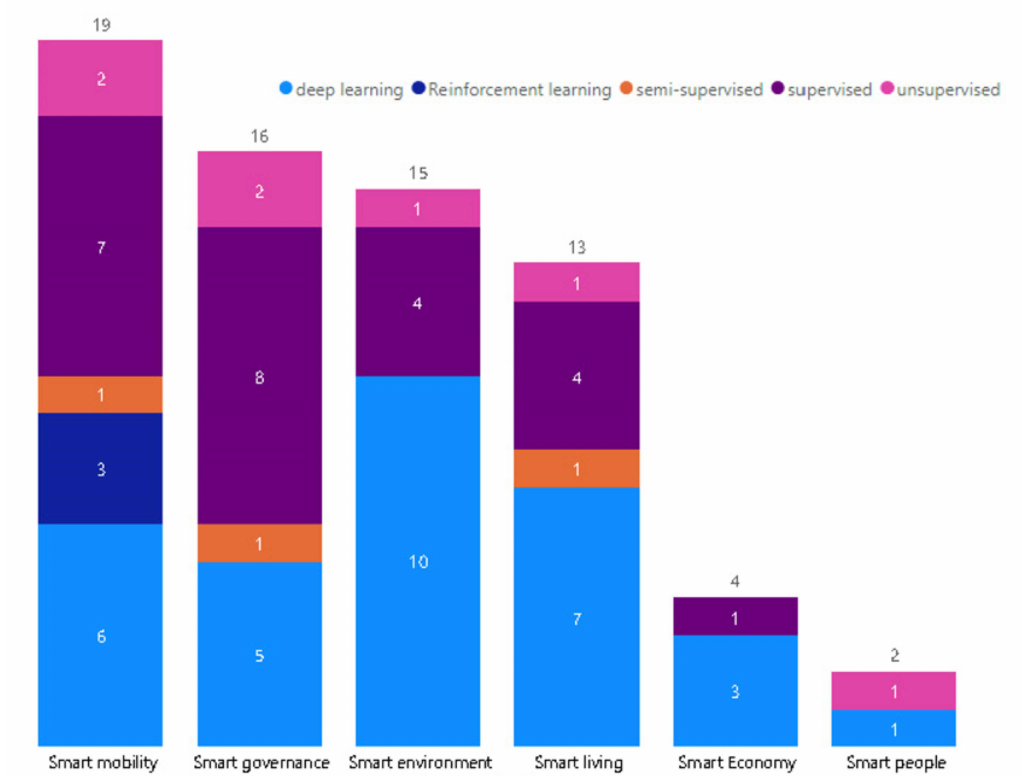
Figure 11. Machine learning techniques used in each of the smart city